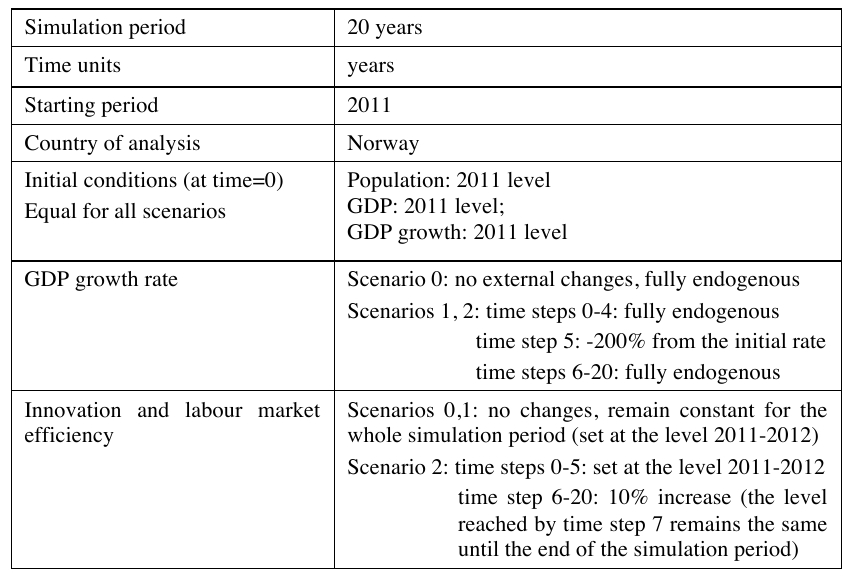
Table 5. Scenario